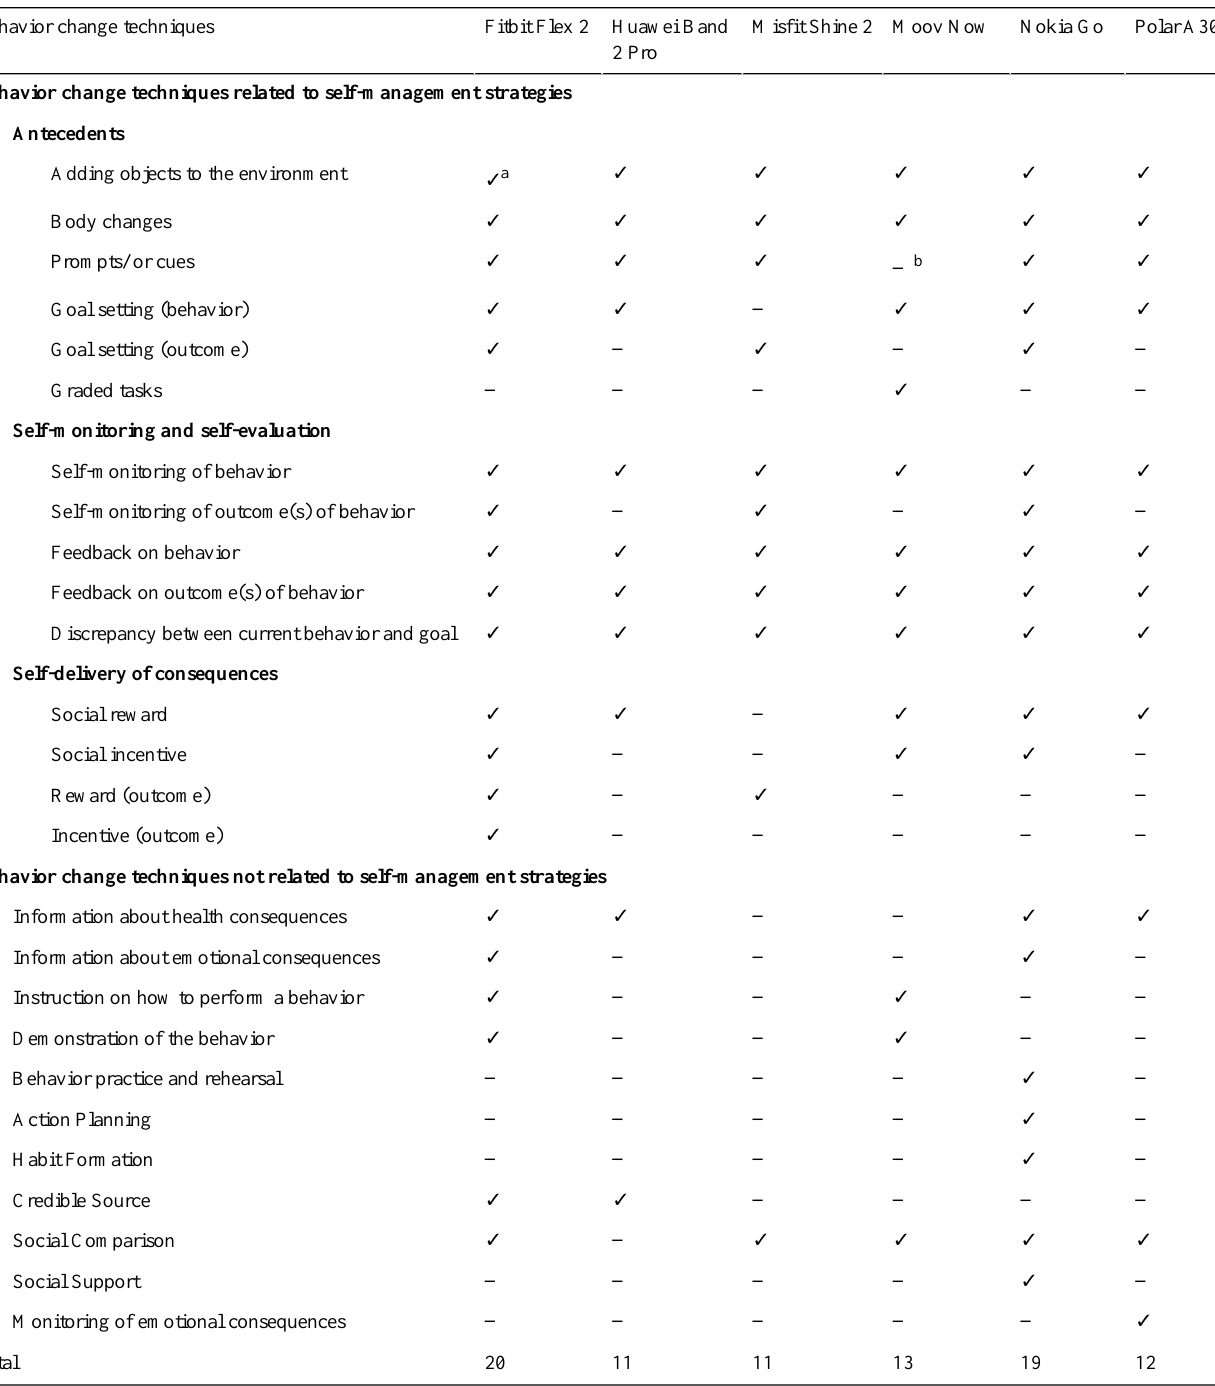
Table 2. Behavior change techniques’effect in increasing physical activity included in each fitness